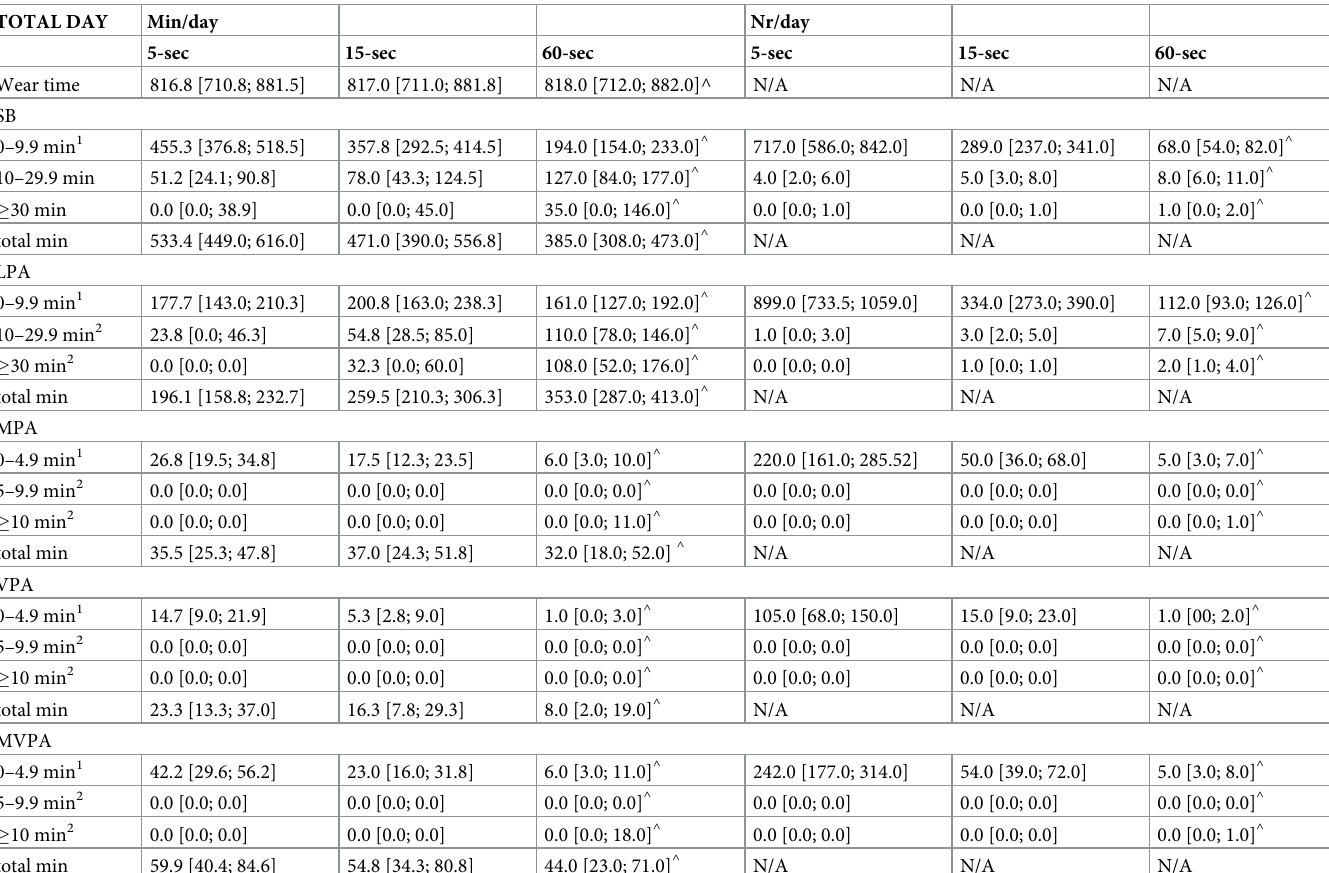
Table 3. Prevalence (duration and frequency; median [25 th -75 th percentiles]) of total and bouts sedentary behaviour and physical activity using different epoch lengths (n = 902